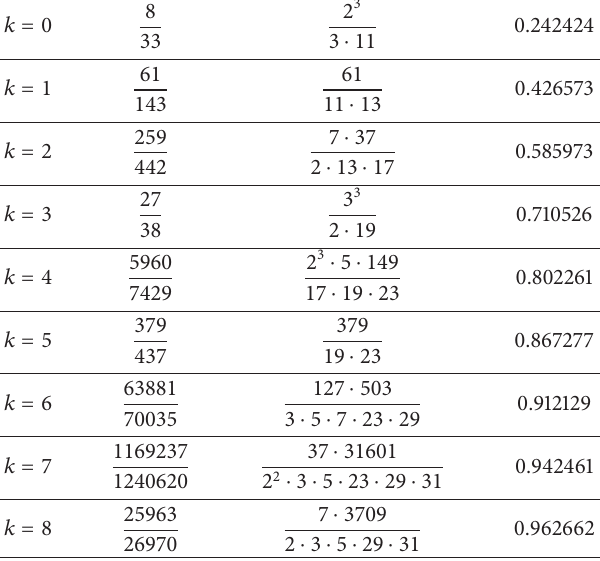
Table 2: Two-qubit ( 𝛼 = 1) separability probabilities.